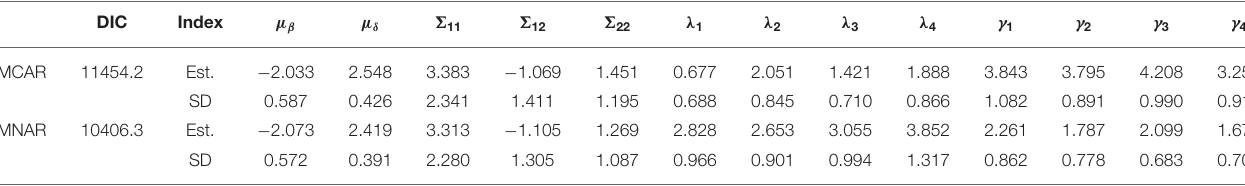
TABLE 6 | Estimates and standard errors of the parameters for the real data.